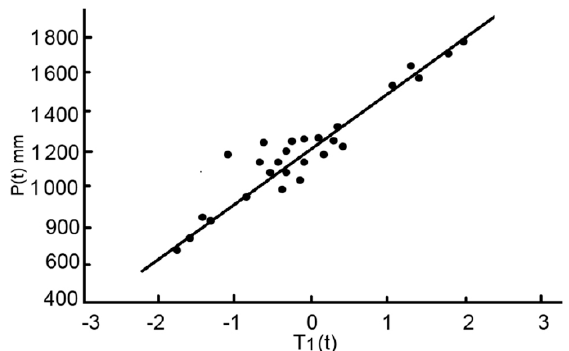
Figure 6. The relationship between P ( t ) and T 1 ( t ) in the Taedong River Basin.